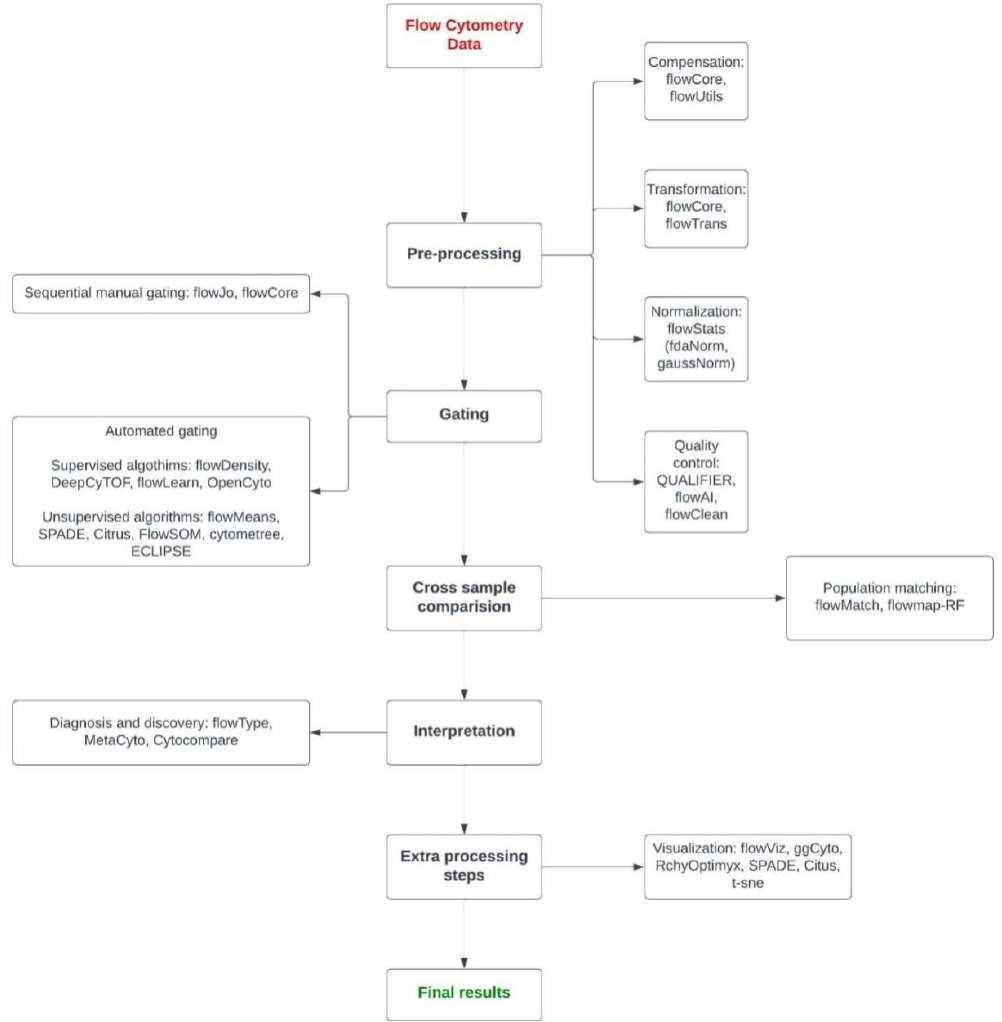
Figure 3. Steps for analyzing flow cytometry data along with packages that can be used at each step.